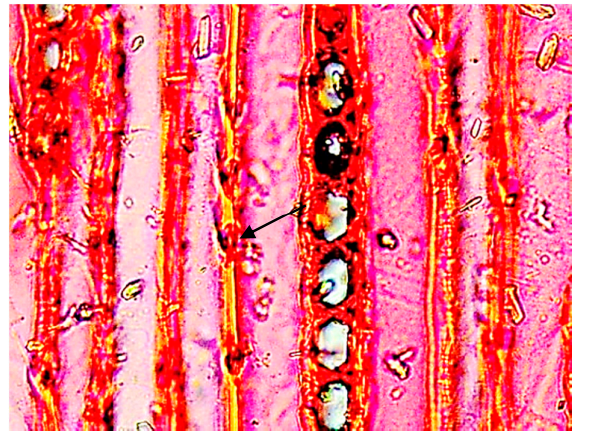
Figure 5. Tracheid pitting in radial walls with torus (earlywood in sapwood zone, tangential